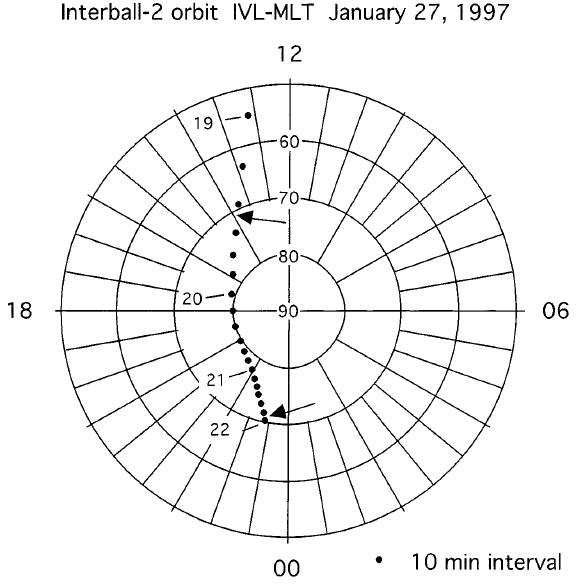
Fig. 8. Orbit of Interball-2 on January